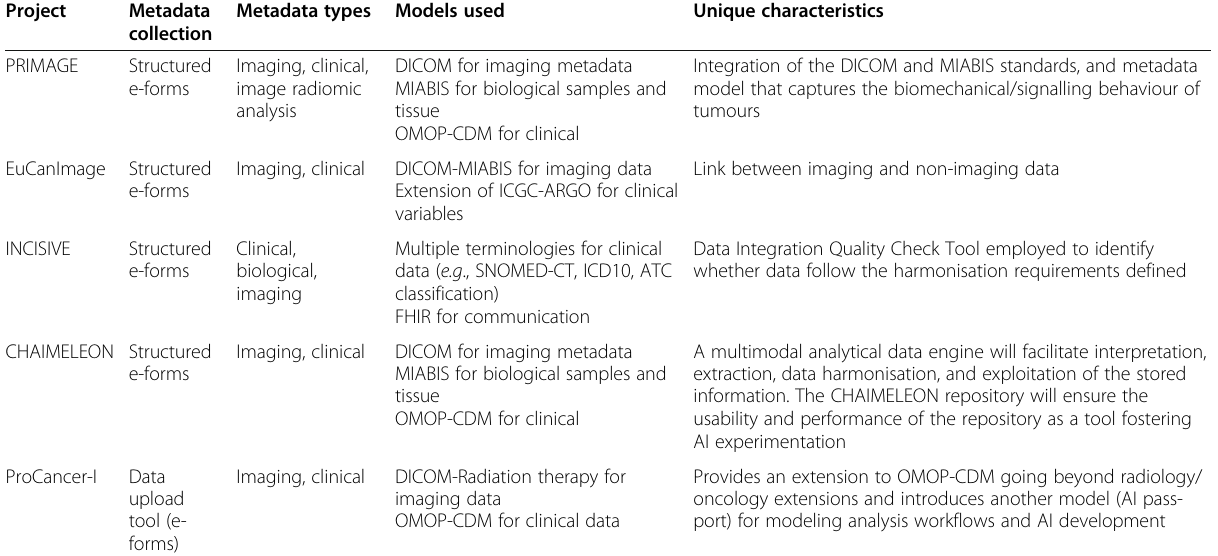
Table 3 Metadata management approaches of the AI4HI projects Project Metadata Metadata types Models collection